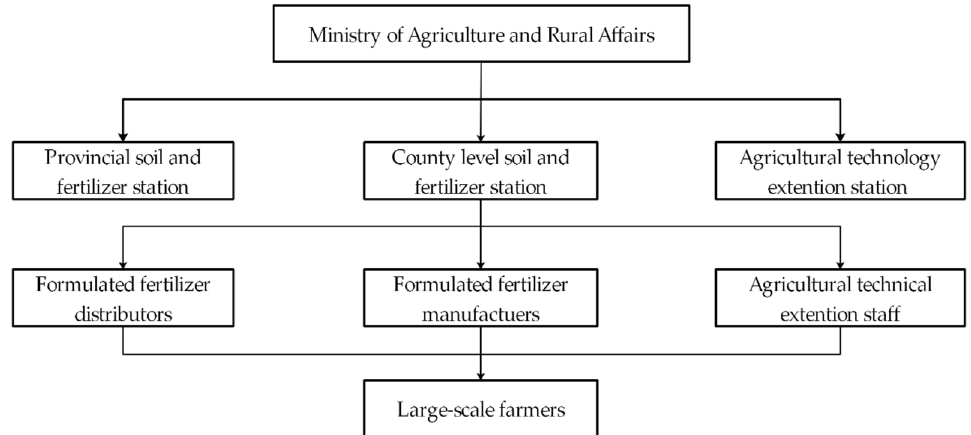
Figure 1. Agricultural Extension Systems of China.